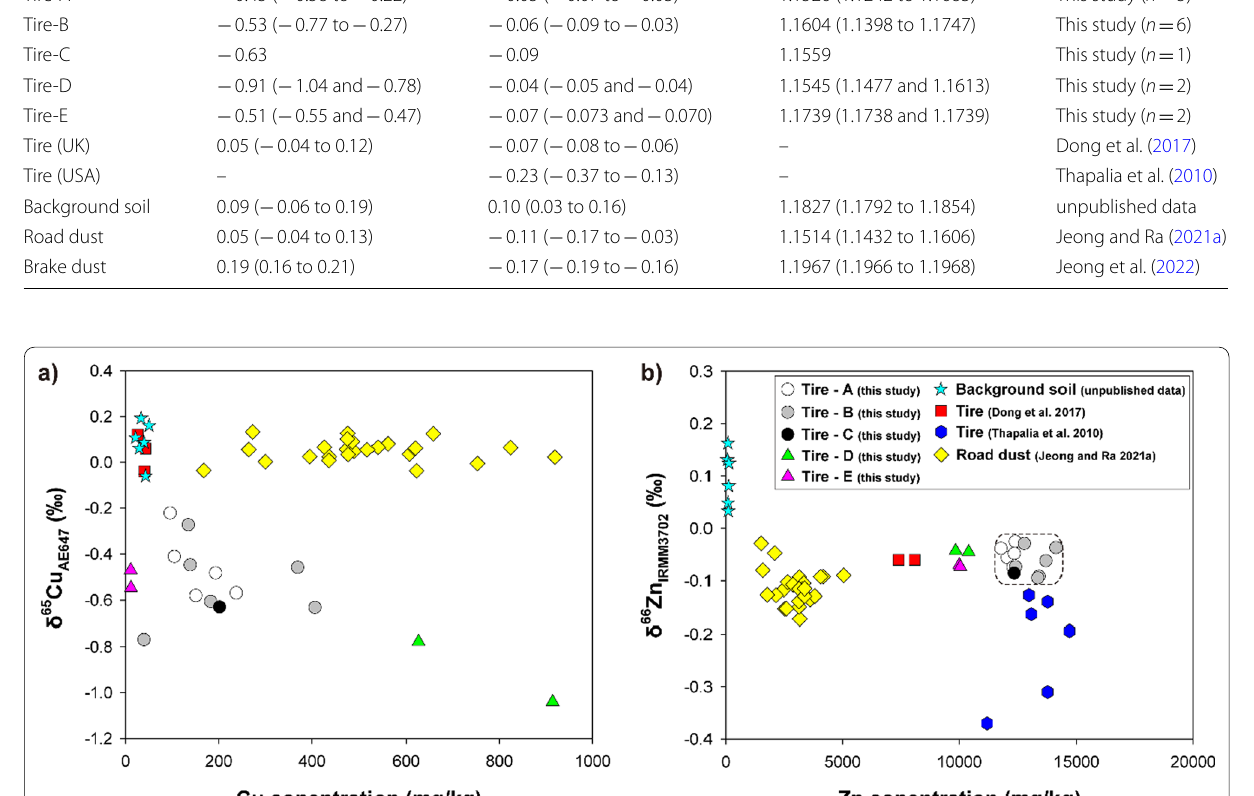
Fig. 2 Plots of concentrations (mg/kg) versus isotopic compositions (δ value) of Cu ( a ) and Zn ( b ) in the tire samples in this study and other